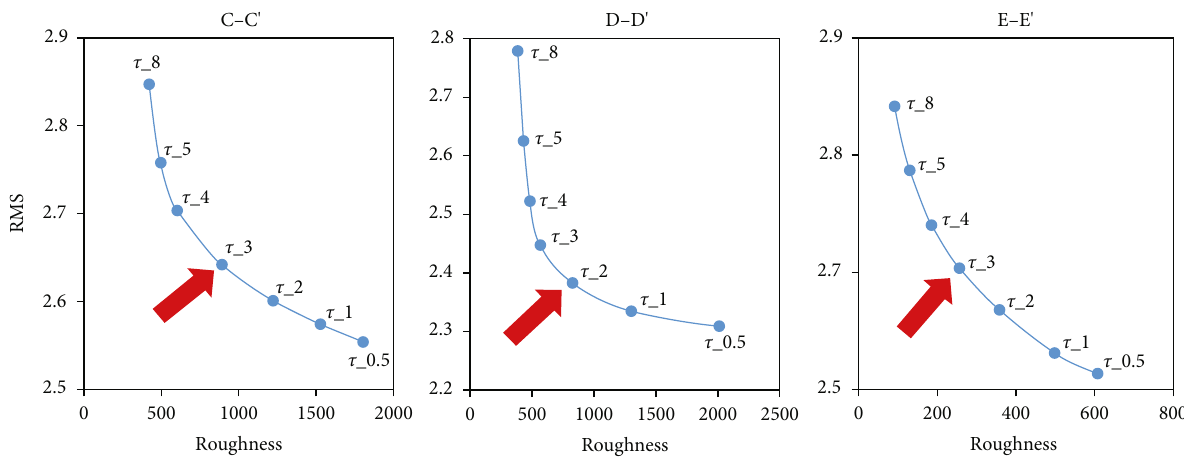
Figure 6: The value of regularization parameter (tau) was obtained from L-curve analysis for MT data line C-C ′ (left), D-D ′ (middle), and E-E ′